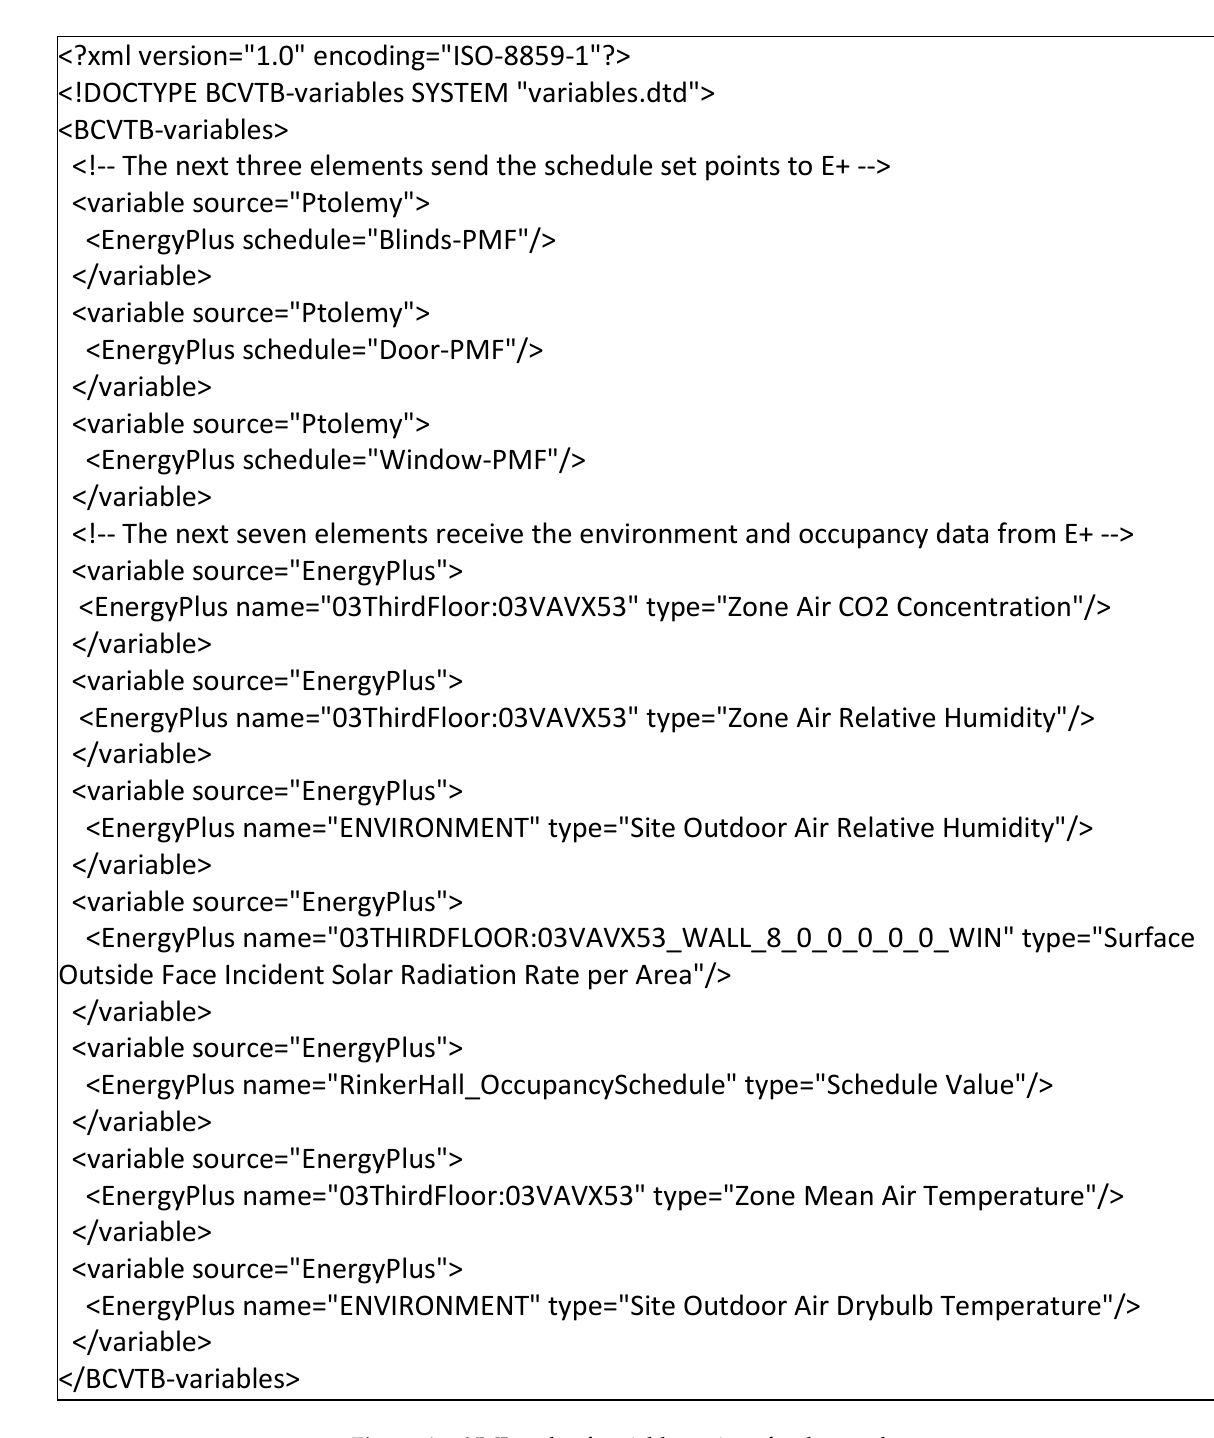
Figure A1. XML code of variable settings for data exchange.